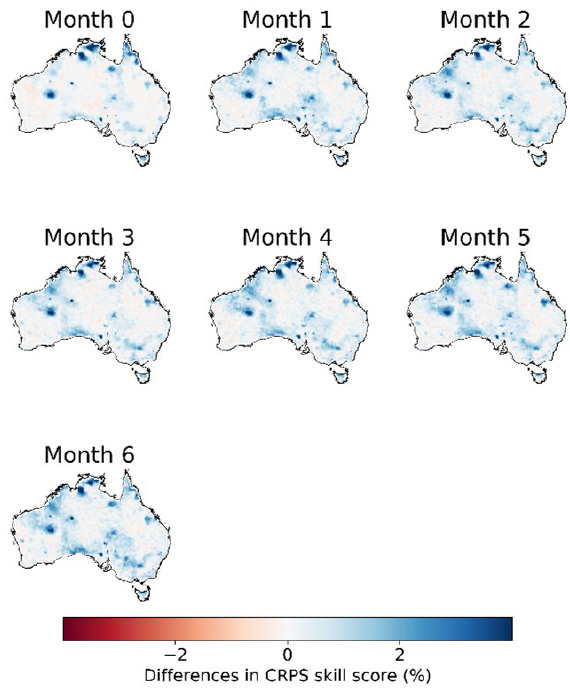
Figure 4. Differences in CRPS skill scores between BJP-ti cali- brated forecasts and the BJP calibrated forecasts over